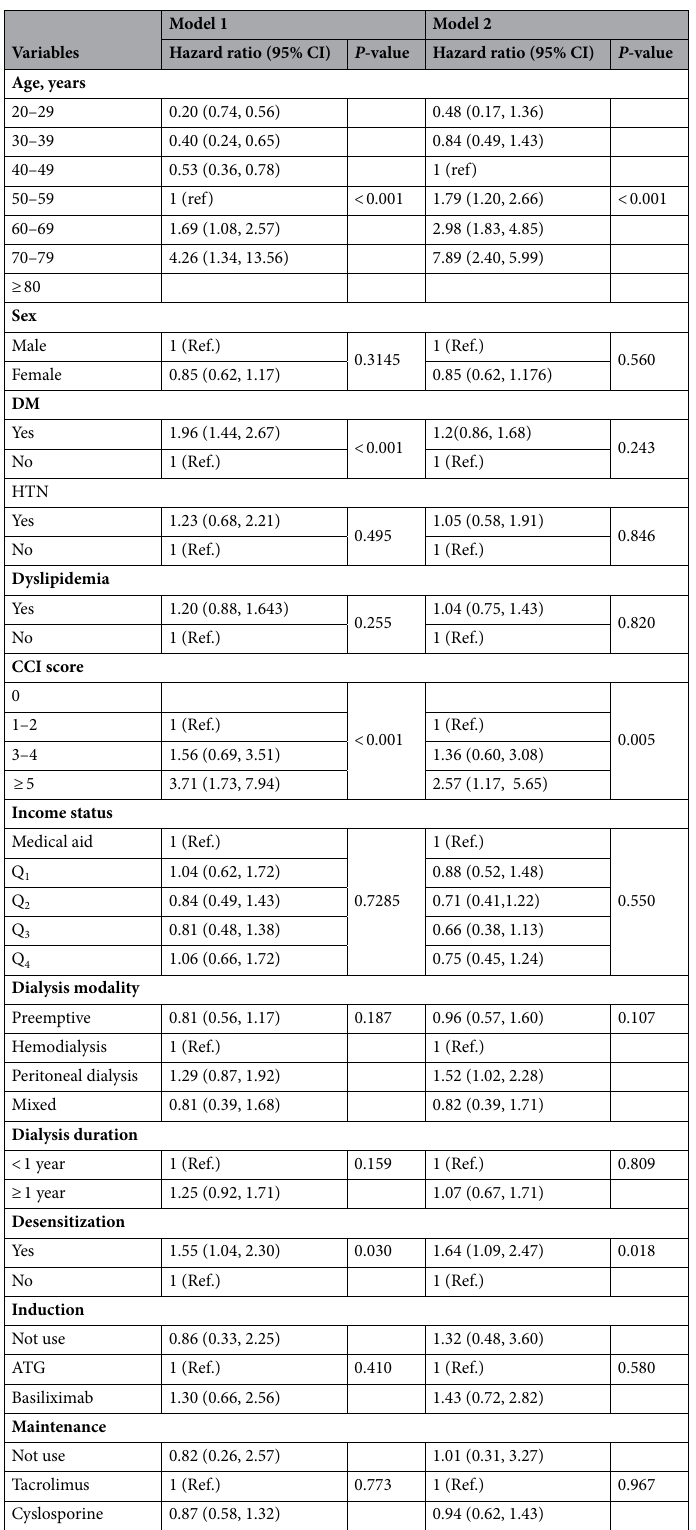
Table 4. Risk factors analysis for RVO in KT group. Analysis was performed using univariable and multivariable Cox regression. Model 1: univariable analysis; Model 2: multivariable Cox proportional